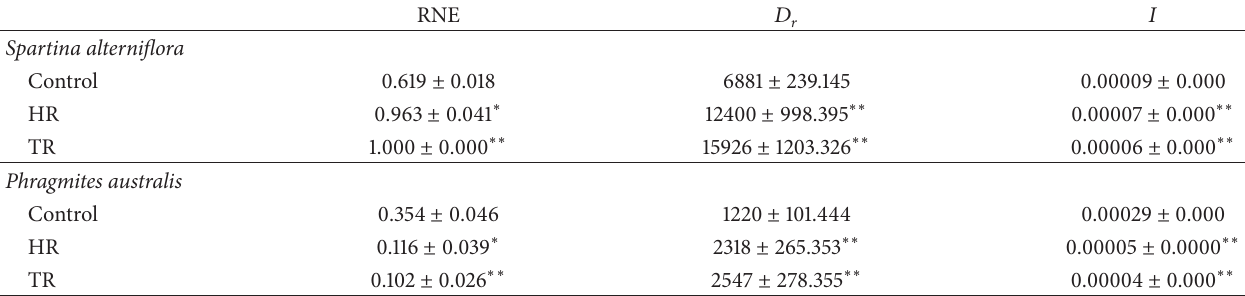
Table 1: The RNE, 𝐷 𝑟 , and 𝐼 of Phragmites australis and Spartina alterniflora in different mowing treatments ( 𝑛 = 10 plots) (mean ± SE). RNE 𝐷 𝑟 𝐼 Spartina alterniflora Control 0.619 ±